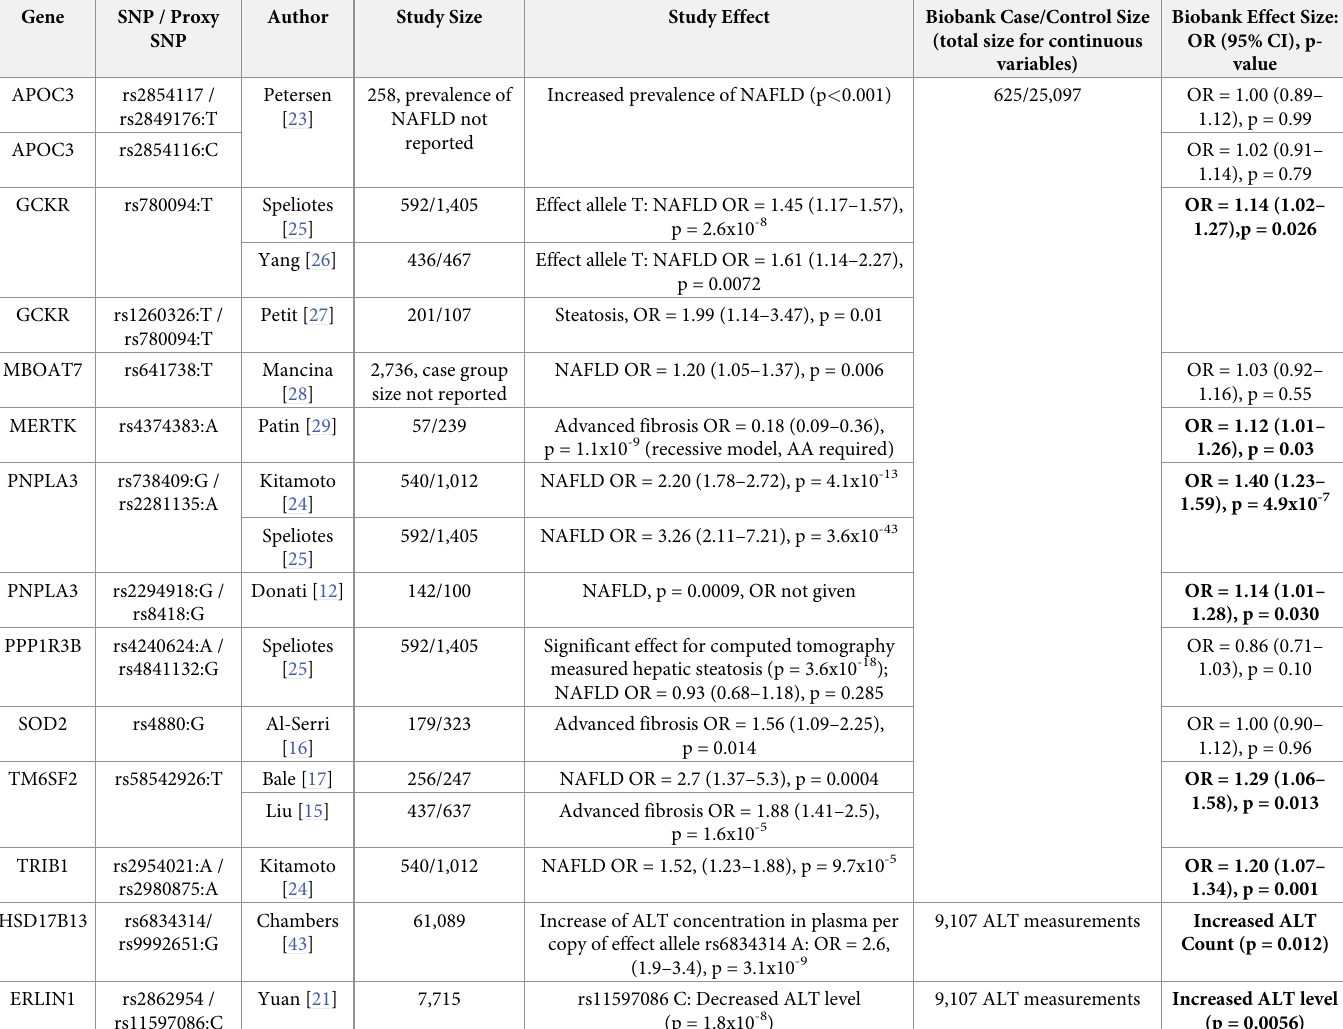
Table 5. Association between genetic variants and NASH/NAFLD diagnosis (K75.8 or K76.0)/laboratory measurements in the Estonian